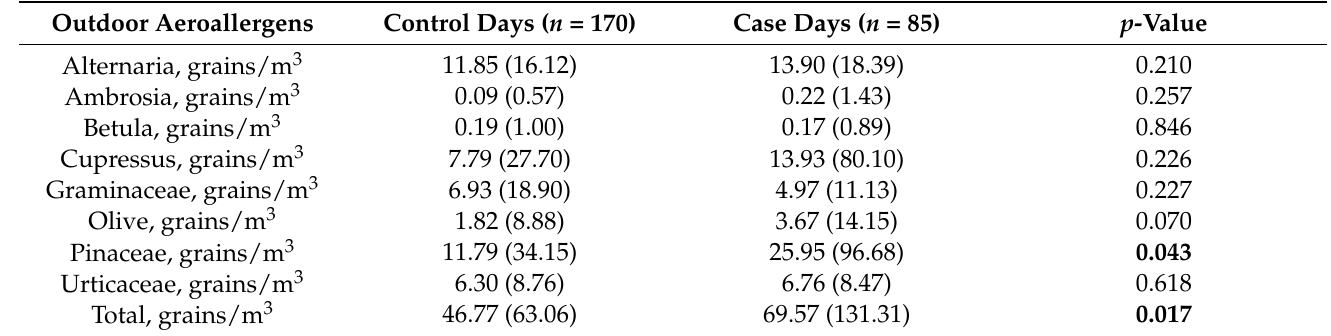
Table 2. Mean (SD) outdoor aeroallergen counts (grains/m 3 ) on the case days (day 0) and on the control days (day − 7 and day + 7). p -values are from two-way ANOVA. Significant effects are in bold.